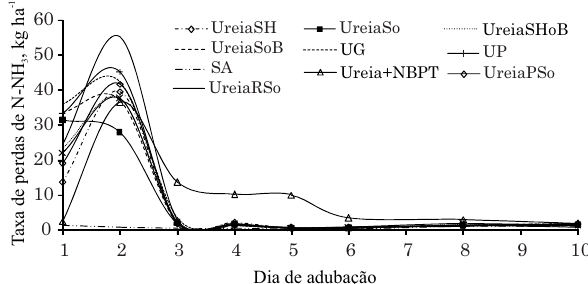
Figura 4. Taxa diária de perdas de N-NH 3 dos diferentes fertilizantes nitrogenados ao longo do